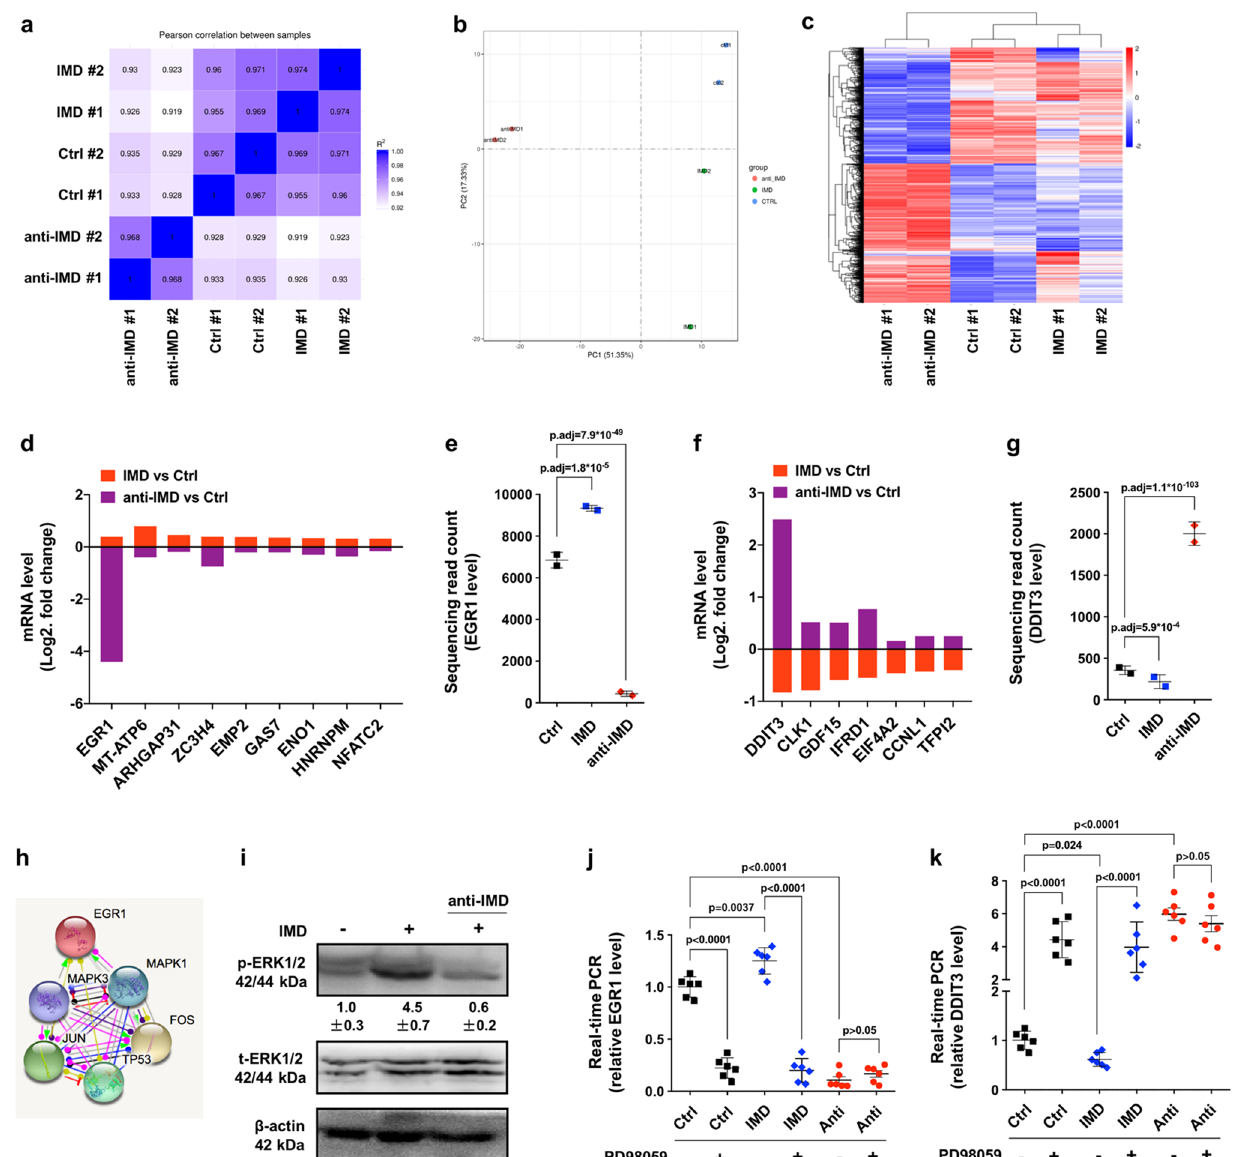
Figure 6. IMD induced phosphorylation of ERK1/2, which significantly increased EGR1 but suppressed DDIT3 transcription. ( a ) The square of Pearson correlation coefficient (R 2 ) of the transcriptome sequencing analysis. R 2 > 0.92 indicates good reliability. ( b ) Principal component analysis (PCA) showed good duplication within groups and significant differences between groups. ( c ) The differentially expressed genes (DEG) heatmap showed IMD or anti-IMD causing significant changes in gene transcription. ( a – c were extracted from the original RNA-Seq report). ( d ) Nine genes were found up-regulated in IMD-treated group, but significantly down-regulated in anti-IMD group. ( e ) The RNA-sequencing read counts of EGR1 in IMD- or anti-IMD- treated group (n = 2). ( f ) Seven genes were found down-regulated in IMD-treated group, but up-regulated in anti-IMD group. ( g ) The RNA-sequencing read counts of DDIT3 in IMD- or anti-IMD-treated group (n = 2). ( h ) The STRING protein interaction analysis of the EGR1 interaction network. ( i ) HCC-15H cells were incubated with IMD or anti-IMD for 10 min and subjected to Western blot assay. The density of the band for p-ERK1/2 (referred to total ERK1/2) is presented relative to that of the control. The mean level in the control group was set to 1.0; n = 3. ( j , k ) HCC-15H cells were pre-treated with PD98059; 60 min later, the cells were incubated with IMD or anti-IMD for 10 min, and the mRNA level of EGR1 or DDIT3 were measured using Real-time RT PCR. The mean level in the control group was set to 1.0; n = 6. Data were presented as scatter plots with mean ± SD ( d , e , f , g , j , k were generated using the software GraphPad Prism 8.0. https ://www.graph pad.com/ scien tific -softw are/prism /); and ( h ) was generated using the online tool STRING, https ://strin g-db.org/cgi/input .pl?sessi onId=o2YSl ODG8A 4I&input _page_show_searc h=on.) Significance was assessed by unpaired t test with Welch’s correction